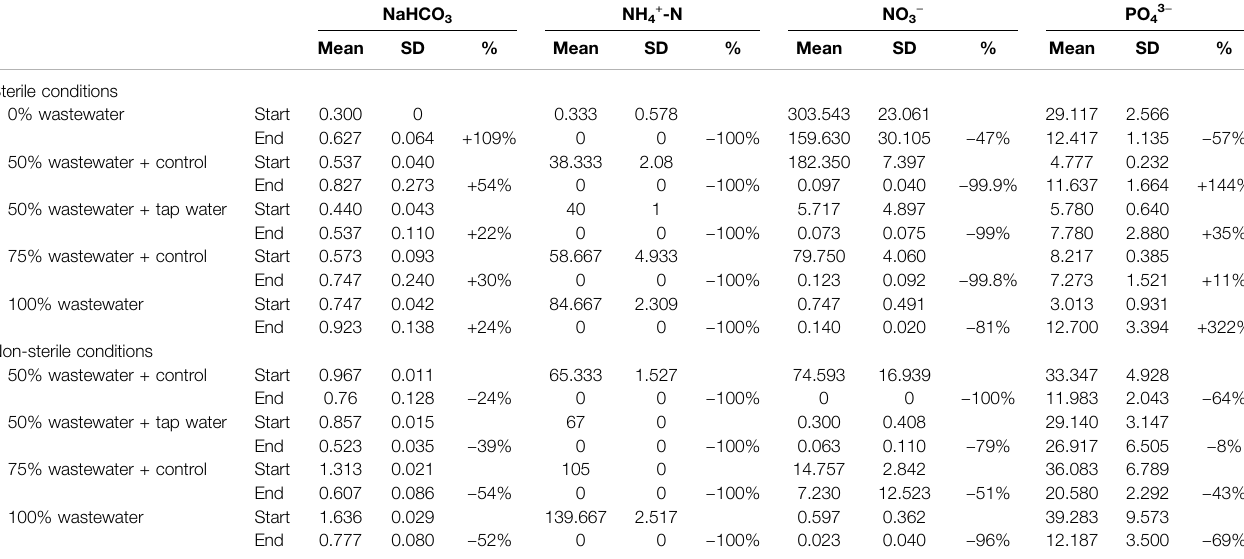
TABLE2| Nutrientconcentrationsinthedifferentgrowthmediaatthebeginningandendoftheexperiment.Meanconcentration,standarddeviation(SD, n (cid:2) 3)andaverage percentual change (%) between start- and end-concentration is given for NaHCO 3 (g L − 1 ), NH 4+ -N (mg L − 1 ), NO 3 − (g L − 1 ) and PO 43 − (mg L − 1